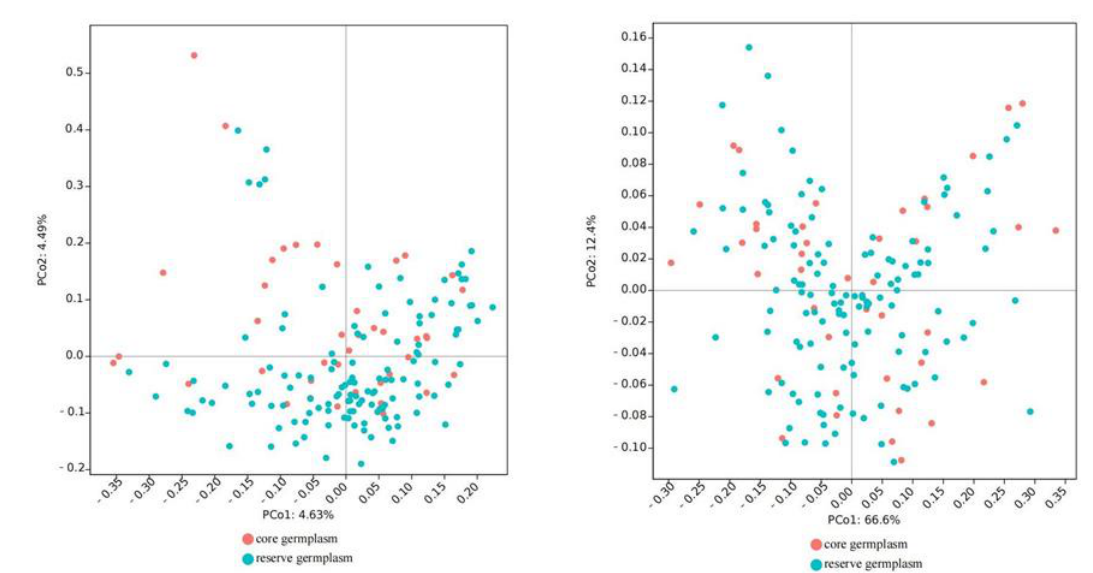
Figure 4. Principal coordinate analysis based on SSR 167 germplasm resources ( left ) and principal coordinate analysis based on fruit traits of 167 germplasm resources ( right ).